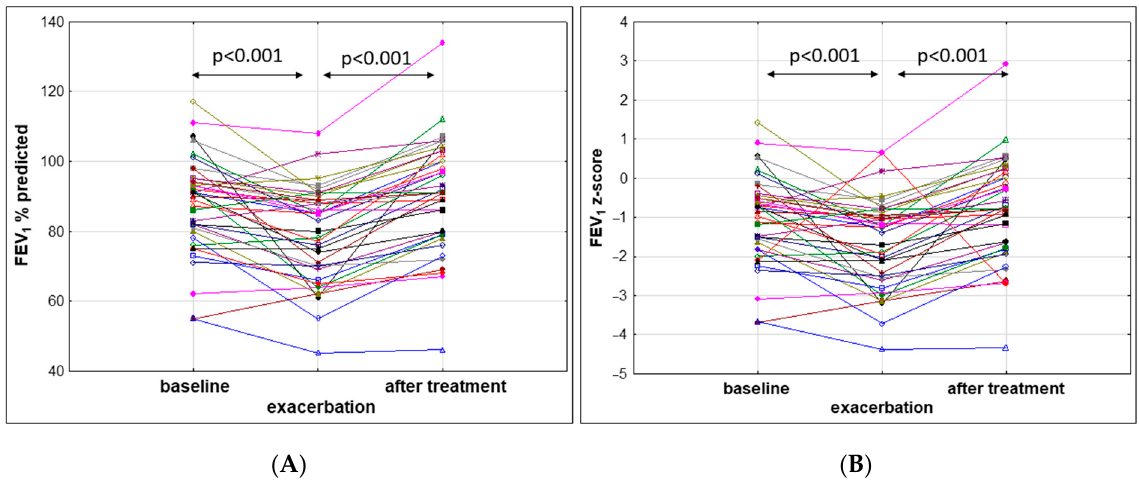
Figure 1. FEV 1 results: ( A ) FEV 1 % predicted and ( B ) FEV 1 z-score for subjects with CF in stable condition, before and after treatment of pulmonary exacerbation.